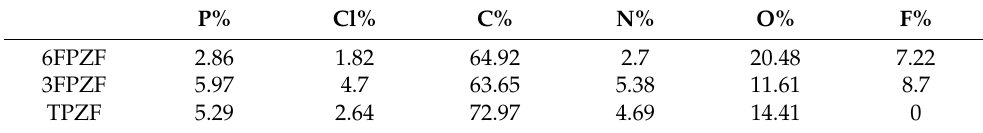
Table 2. Atomic concentrations of the polyphosphazene microsphere